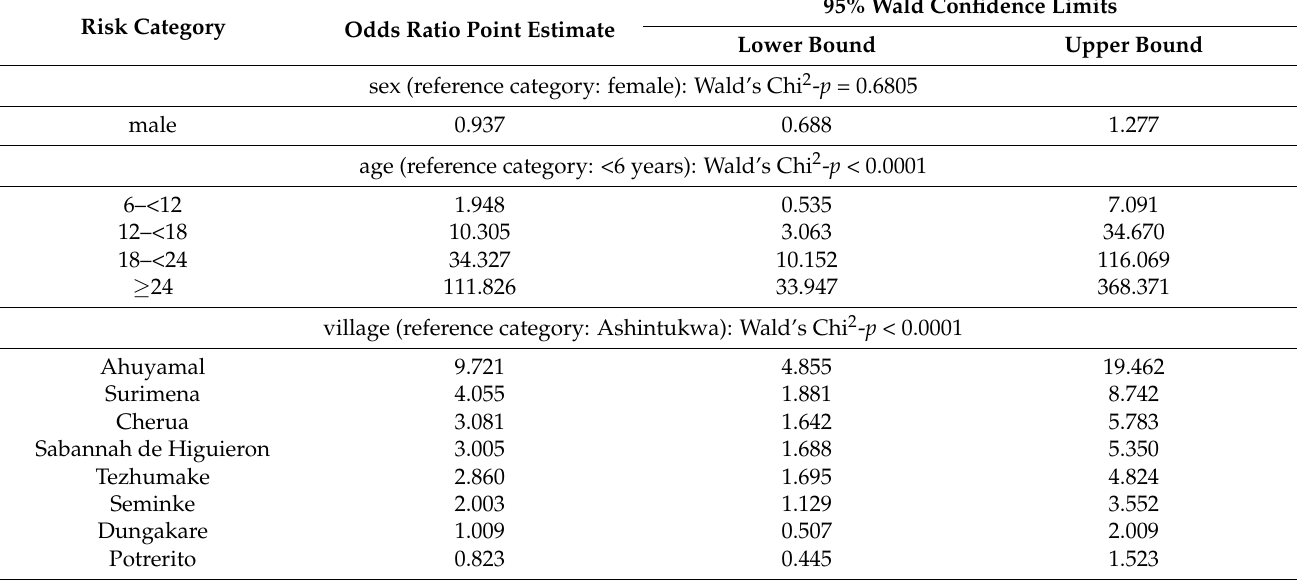
Table 5. Adjusted odds ratio estimates from multi-factorial logistic regression in the entire study population ( n =